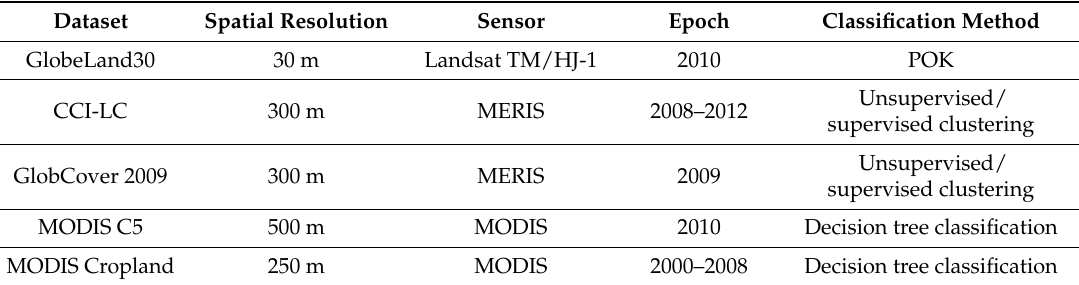
Table 1. Characteristics of the five cropland datasets.